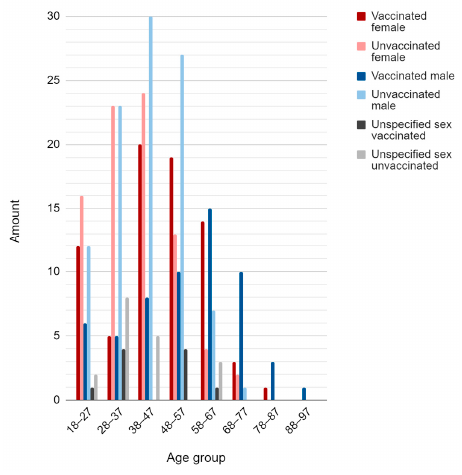
Figure 3. Amount of people divided into age group, vaccination, and sex.